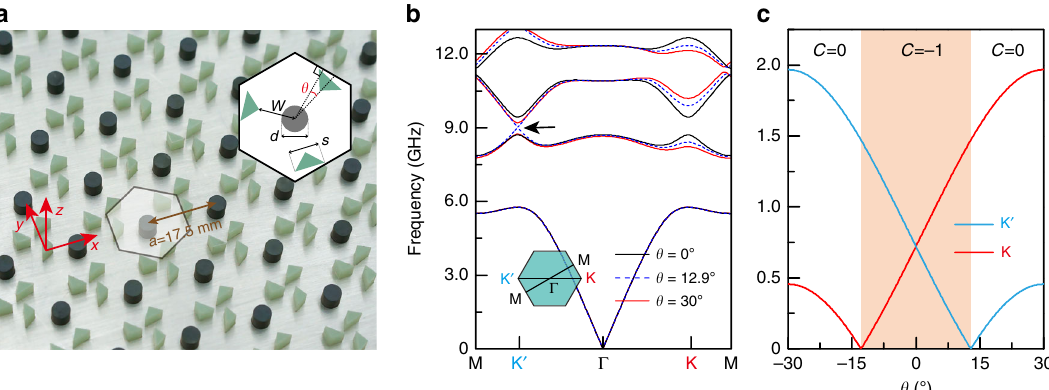
Fig. 1 Recon fi gurable gyromagnetic photonic crystals (PhCs). a Photograph of the PhC sample in a parallel-plate waveguide. The spacing between the upper and lower aluminum plates is 4 mm. Inset: schematic of a unit cell, which consists of a gyromagnetic cylinder (dark gray circle) and three dielectric right-triangular pillars (green triangles). The gyromagnetic cylinder has diameter d = 0.24 a , and the right-triangular pillars have hypotenuse widths s = 0.28 a . The distance between the unit cell center and nearest triangular vertices is w = 0.33 a . The angle θ indicates the orientation of the triangular pillars within the unit cell, relative to the three primitive vectors of the hexagonal lattice. In the depicted con fi guration, θ = 12.9°. b PhC bandstructures under a 0.4 Tesla external magnetic fi eld for θ = 0°, 12.9°, and 30°. For PhC at θ = 12.9°, an unpaired Dirac point appears at Κ ′ (indicated by the black arrow). c Widths of the bandgap between the second and the third band at K and Κ ′ , as a function of θ . The bandgap at Κ ′ ( K ) closes when θ = 12.9° ( θ = − 12.9°). For | θ |<12.9°, highlighted in light orange, the bandstructure has a topologically nontrivial bandgap, with the fi rst band having a numerically calculated Chern number of C = − 1 (Supplementary Fig.